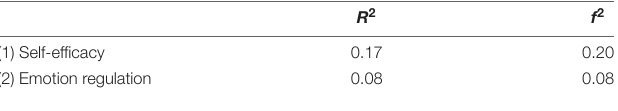
TABLE 3 | Standardized parameter estimates for the structural